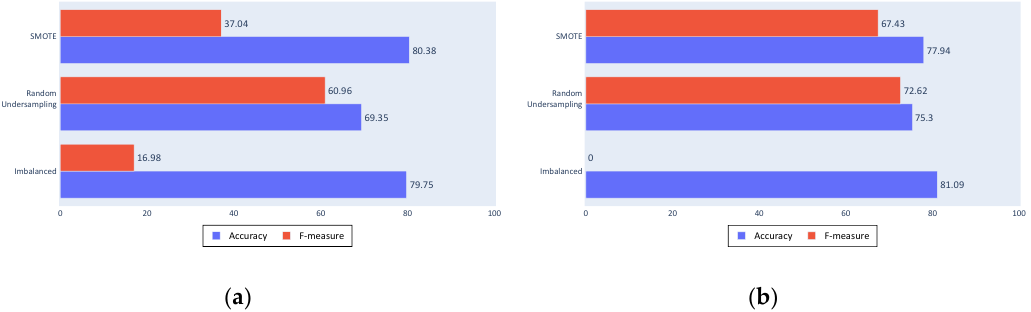
Figure 12. ( a ) Decision tree results with reduced inputs; ( b ) SVM results with reduced inputs.